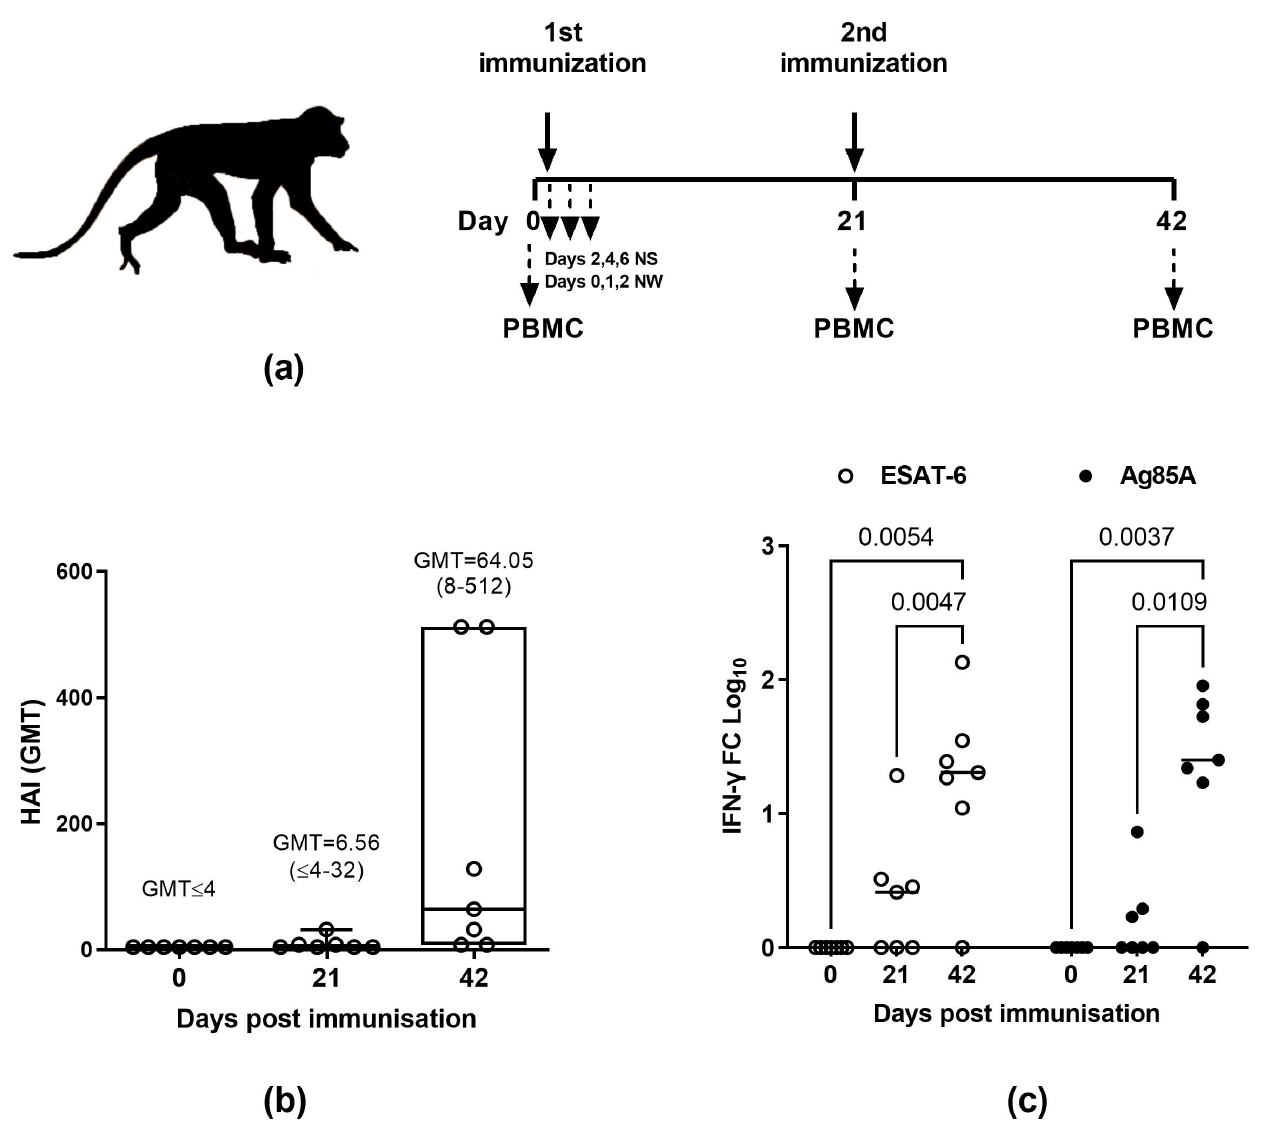
Figure 4. Immunogenicity of TB/FLU-04L in Macaca fascicularis . ( a ) Study timeline and sampling schedule. ( b ) Vector-specific antibody response in HAI and ( c ) antigen-specific IFN γ response (fold change [FC] log 10 ) after the i.n. vaccination with TB/FLU-04L: seven adult male Macaca fascicularis were immunized twice with TB/FLU-04 (7.5 log 10 TCID 50 /animal), with a three-week interval between vaccinations. Blood samples for HAI assay and PBMCs were collected before